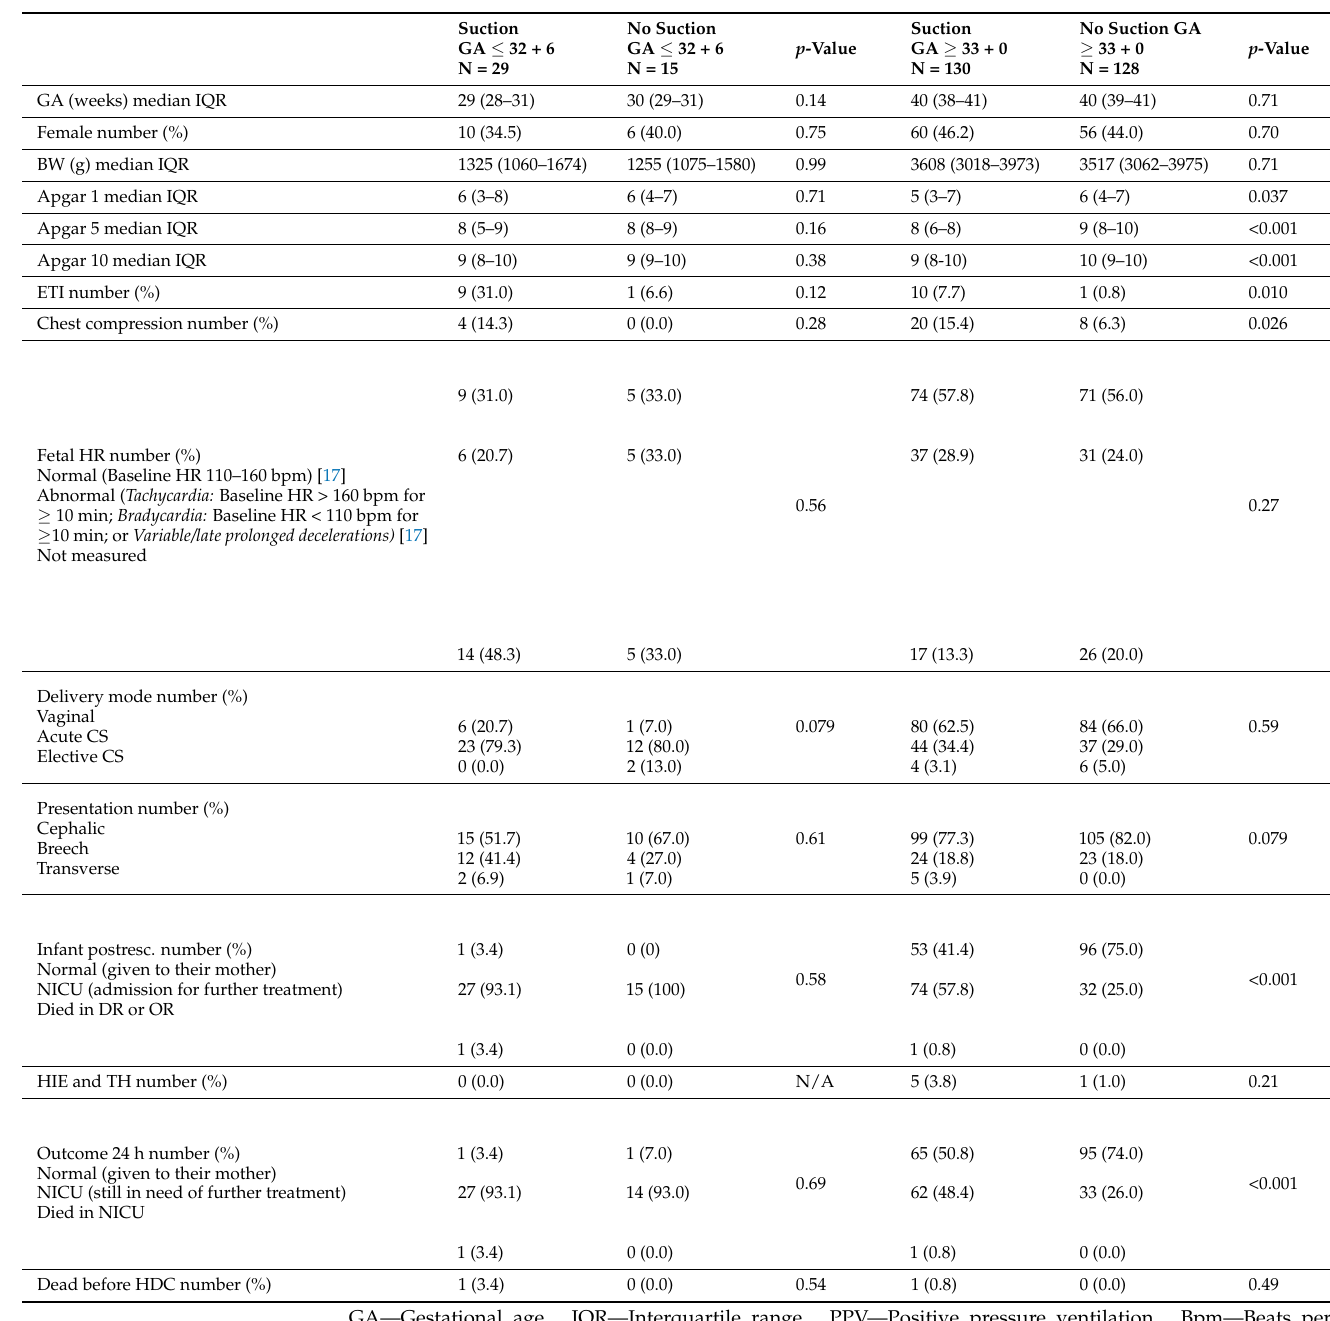
Table 1. Characteristics and immediate outcomes of suctioned ( n = 159) and non-suctioned ( n = 143) preterm and late preterm/term infants who also received